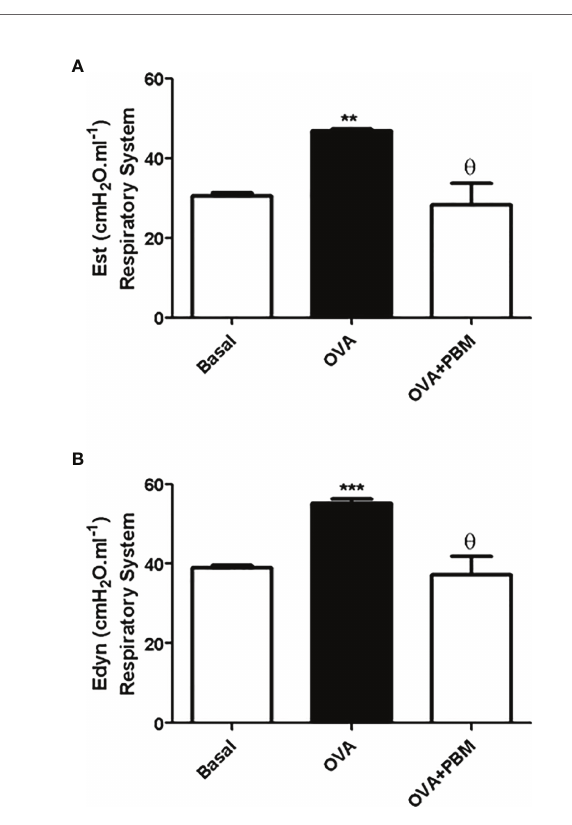
FIGURE 7 | Effect of treatment of photobiomodulation on static (A) and dynamic (B) elastance in the respiratory system (closed chest). Basal group, n = 5; OVA group, n = 7; PBM group, n = 5; OVA+ PBM, n = 8. Two independent sets of experiments were carried out. Data are expressed as mean ± SEM. **p < 0.01; ***p < 0.001 in relation to the Basal group; Ɵ p < 0.001 in relation to the OVA group.